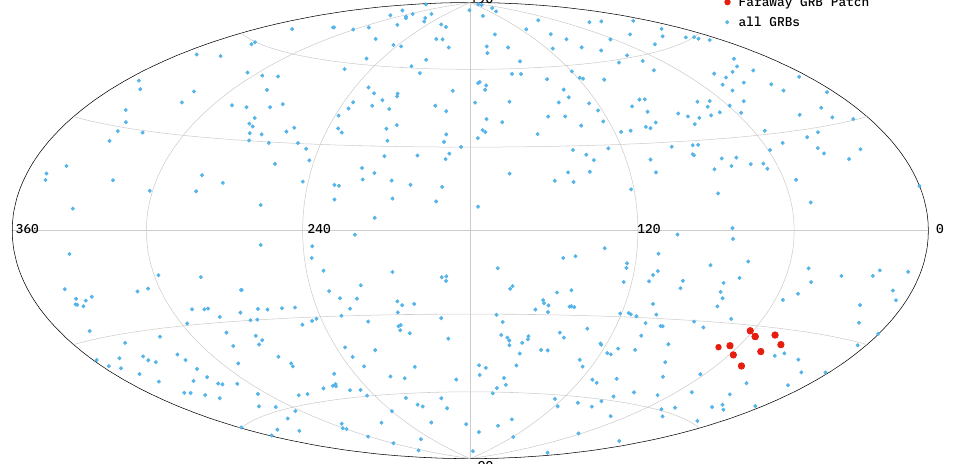
Figure 6. The sky distribution of the Faraway GRB Patch among all GRBs. The angular size is quite small, below the Sky Exposure Function’s optimal smoothing Gauss kernel size (Section